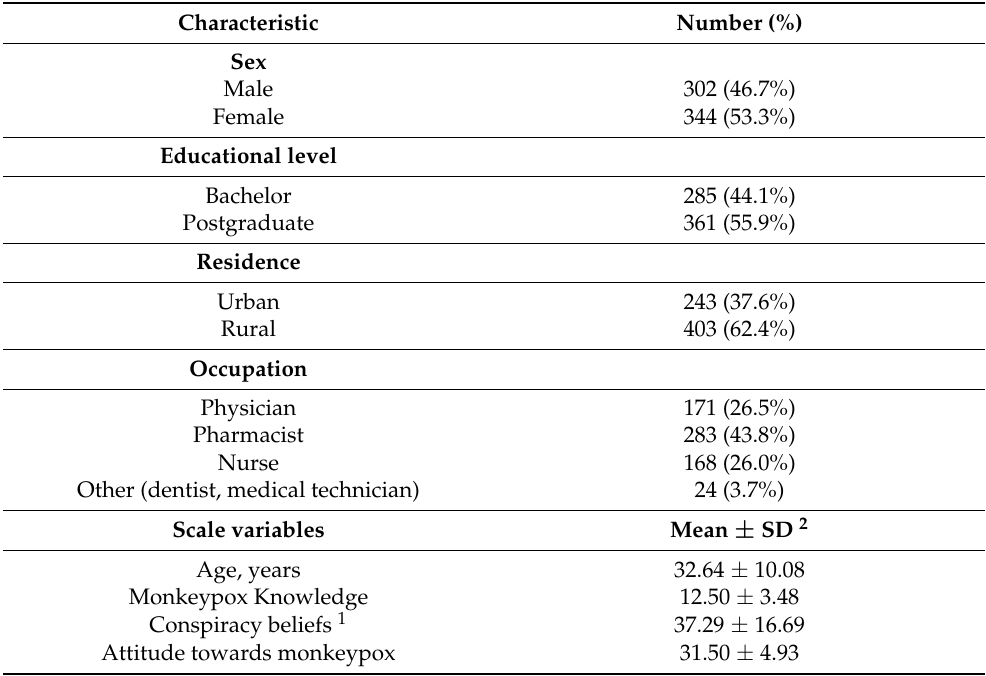
Table 1. Sociodemographic and other characteristics of the participants ( n =